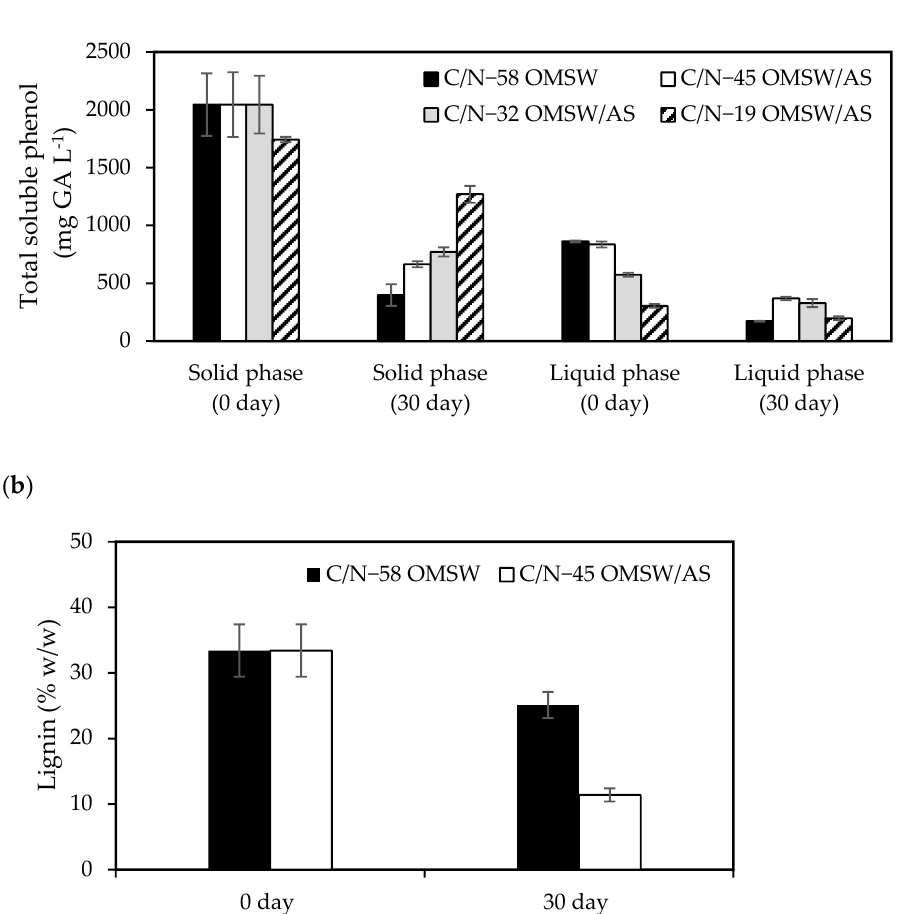
Figure 1. Total soluble phenols in the solid and liquid phase ( a ) of the pre-treatments at initial time and 30 days and lignin removal ( b ) at the same times.